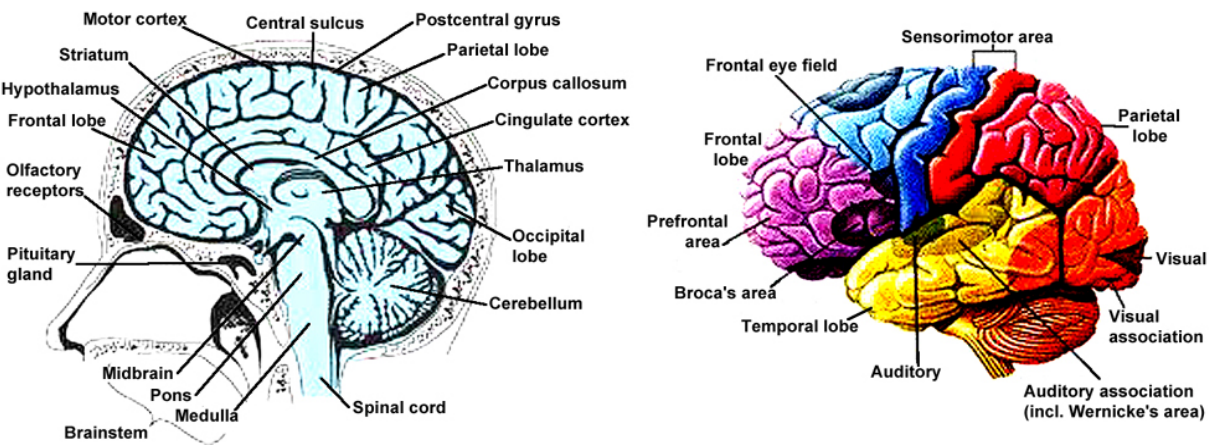
Figure 9. Section (left) and left view of the human